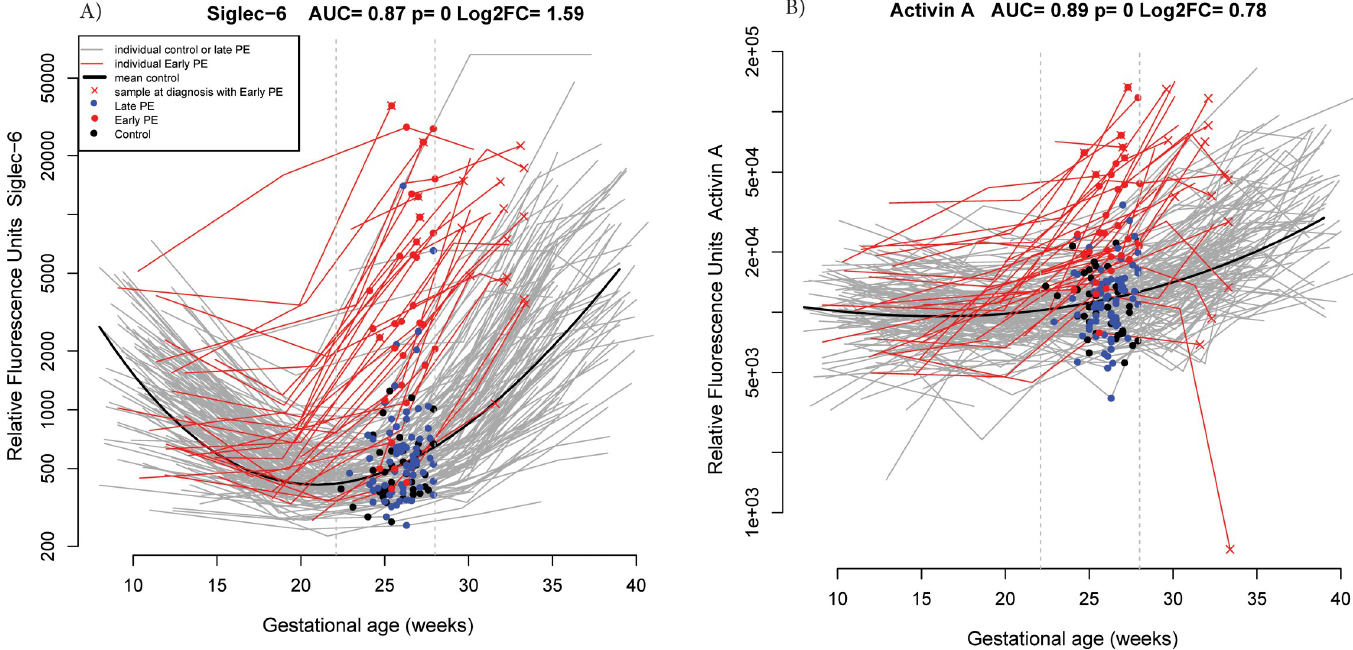
Fig 6. Longitudinal maternal plasma abundance of siglec-6 (A) and activin-A (B) in normal pregnancy and early preeclampsia, highlighting differences at 22.1–28 weeks. Blue dots correspond to samples taken from late preeclampsia cases. AUC: area under the receiver operating characteristic curve; early PE: early preeclampsia; FC: fold change; late PE: late preeclampsia; Siglec-6: sialic acid binding immunoglobulin-like